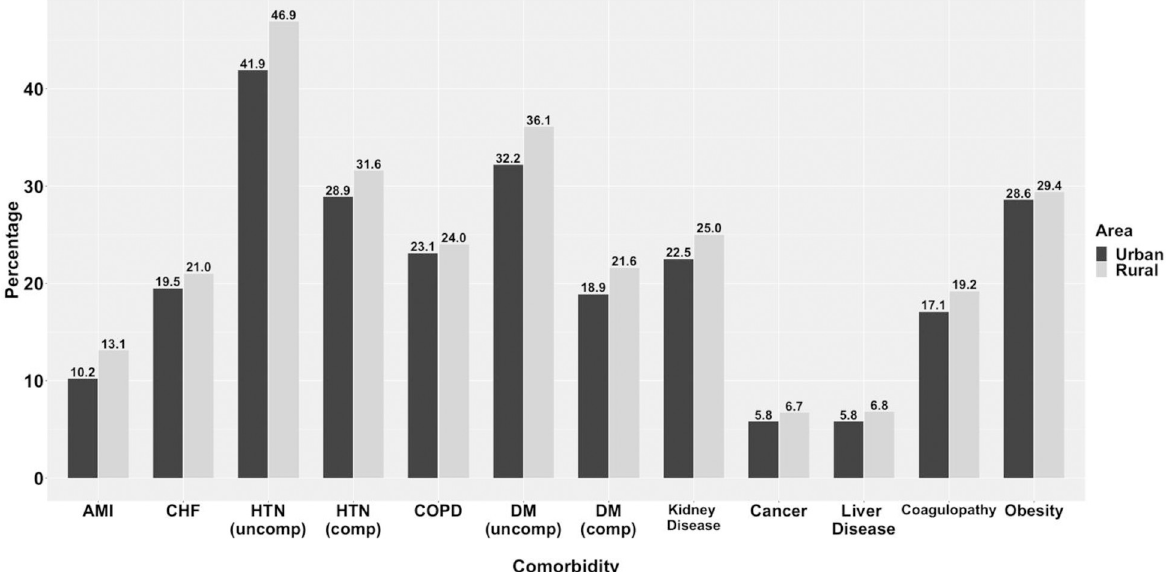
Fig 2. Comparison of rural and urban areas by comorbidity. Comparison of unadjusted comorbidity incidence between rural and urban residents hospitalized in North Carolina for COVID-19. AMI: Acute Myocardial Infarction, CHF: Congestive Heart Failure, HTN: Hypertension, COPD: Chronic Obstructive Pulmonary Disease, DM: Diabetes Mellitus.